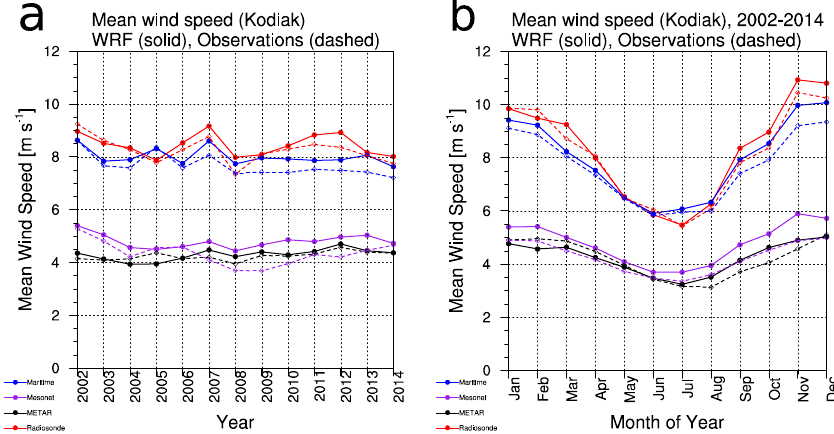
Figure 15. Mean wind speed across the Kodiak region for WRF (solid lines) and observed (dashed lines) wind speed, for maritime (blue lines), mesonet (purple lines), METAR (black lines), and radiosonde (red lines) stations, averaged ( a ) by year, and ( b ) by annual cycle.